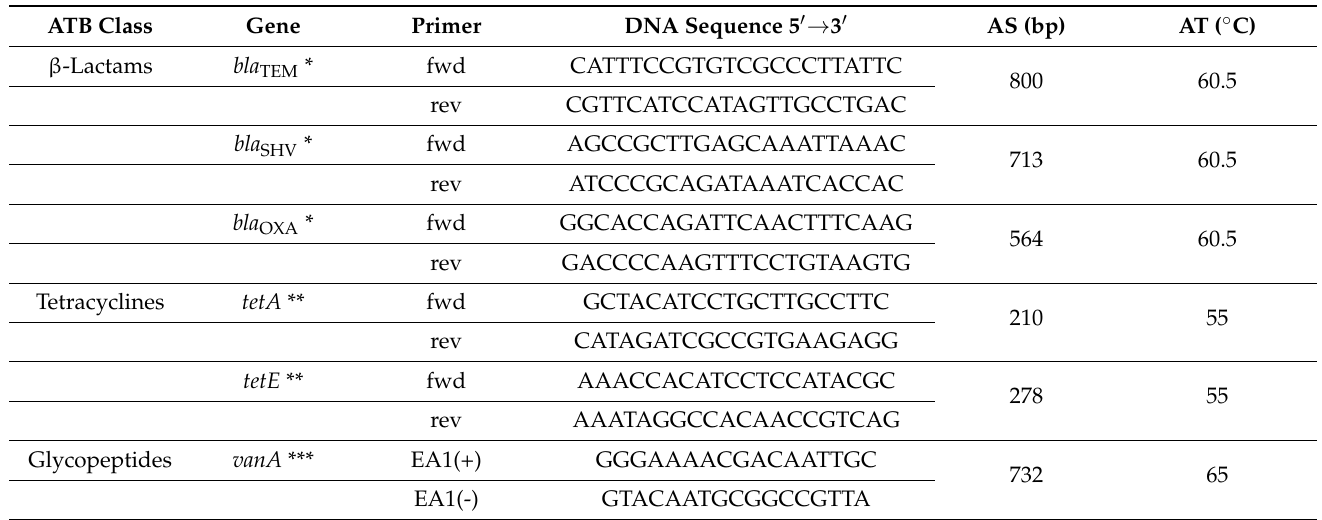
Table 4. Resistant genes detected during PCR in resistant coliform